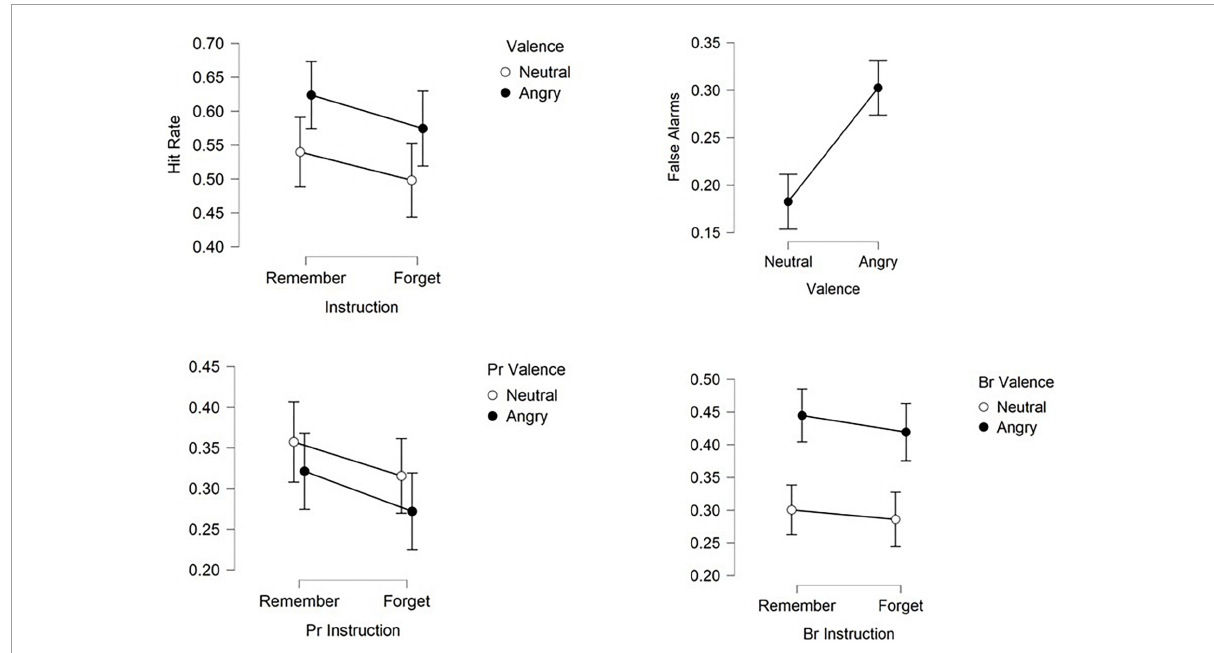
FIGURE2 Hit rates, false alarms, recognition accuracy (Pr) and recognition bias (Br) for angry and neutral faces previously designated to be forgotten or to be remembered. Shown are means ± confidence intervals.